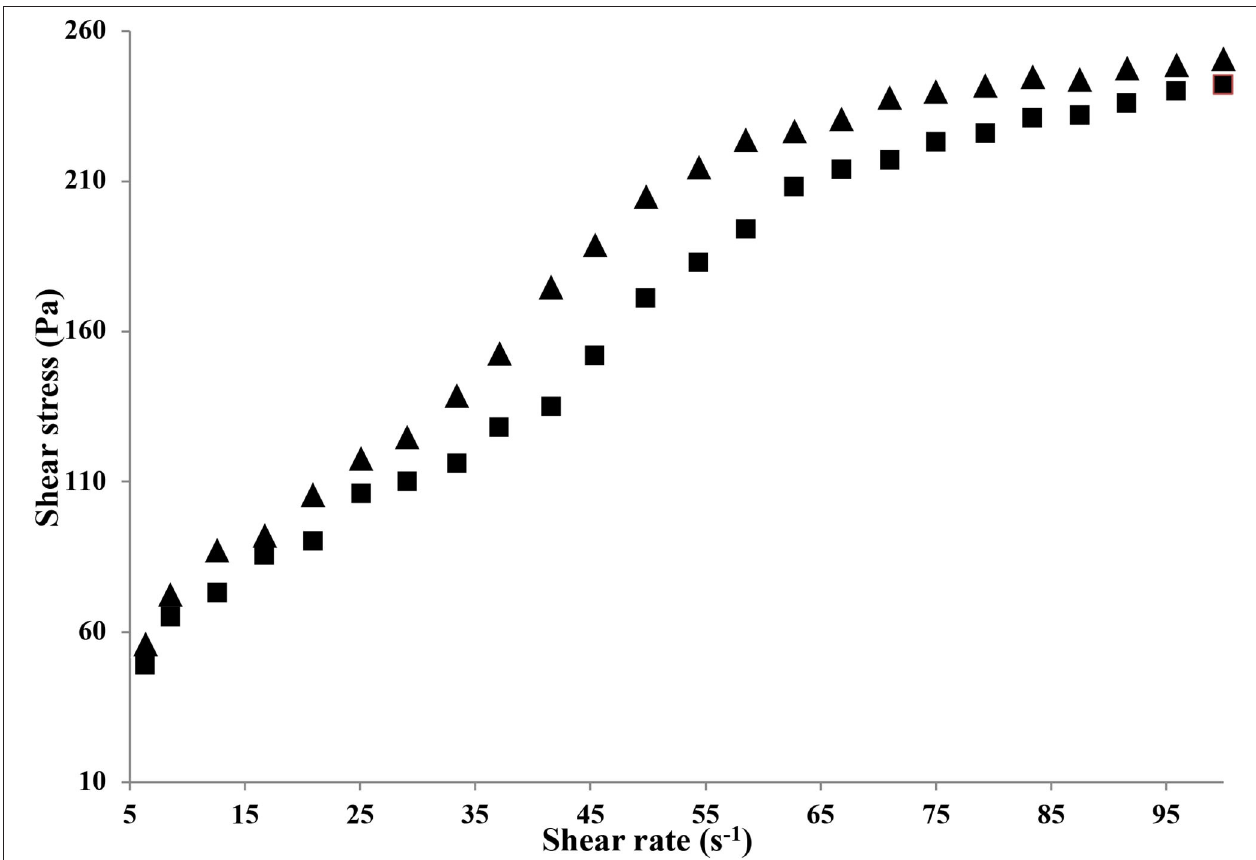
FIGURE 3 | Flow behavior of HAD ( N ) and FD ( (cid:4) ) gelatin